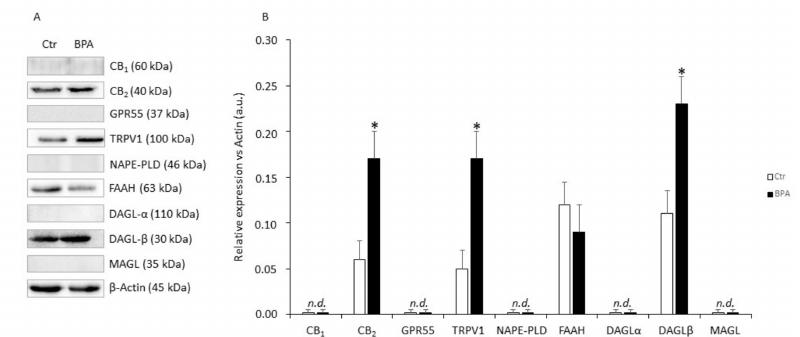
Figure 4. Protein expression levels of eCB system in mouse Sertoli cells. ( A ) Representative Western blot and ( B ) densitometric analysis of eCB-binding receptors and metabolic enzymes in Sertoli cells exposed to BPA (0.5 µ M for 48 h) or to vehicle (Ctr). Data were expressed as mean values (arbitrary units a.u.) ± SEM ( n = 3 independent experiments) after normalization with β -actin, used as loading control. * p < 0.05 vs. Ctr.